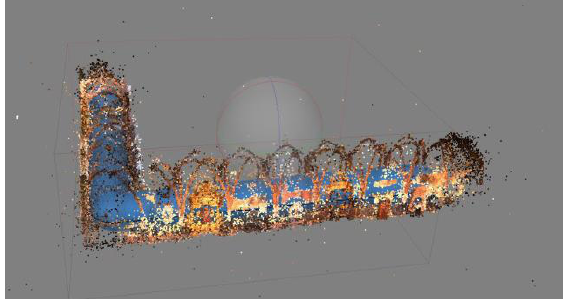
Figure 14. A geometry of the cloisters created in Agisoft Photoscan from imported panoramas extracted from immersive video.